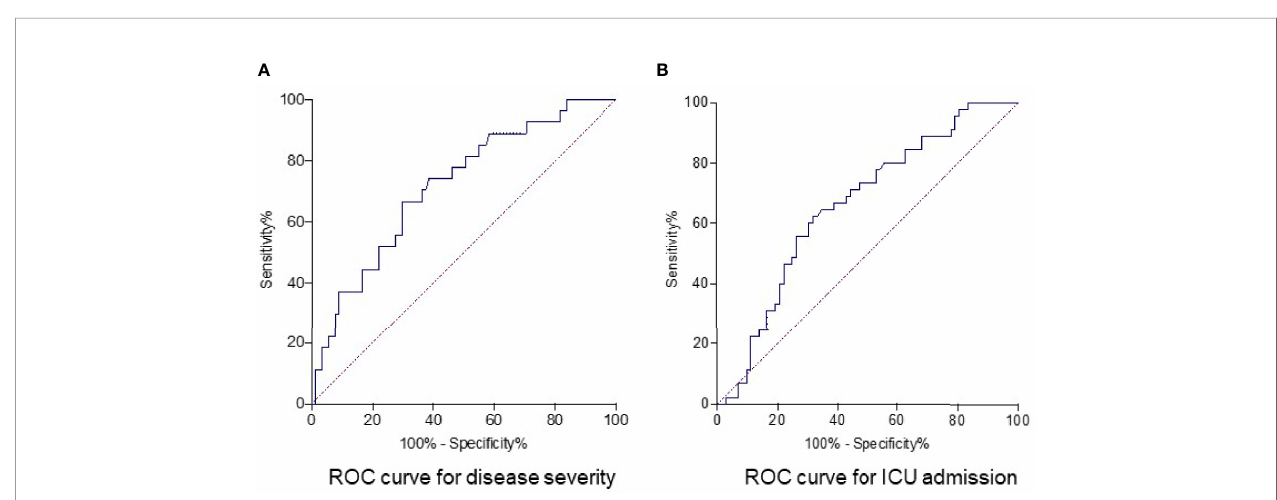
FIGURE 3 | Receiver operating characteristics curve for fi brinogen as parameter for predicting disease severity and ICU admission in COVID-19 patients. The optimum cutoff point of fi brinogen to predict severe disease in COVID-19 was 528.0 mg/dl, with 66.7% for sensitivity and 70.3% for speci fi city. Area under receiver operator characteristic curve (AUC) was 0.72 and P value was 0.0006 (A) . The optimum cutoff point of fi brinogen to predict ICU admission of COVID-19 patients was 571.0 mg/dl, with a sensitivity and speci fi city of 62.2% and 68.1%. The AUC was 0.66 and P value was 0.0037 (B)